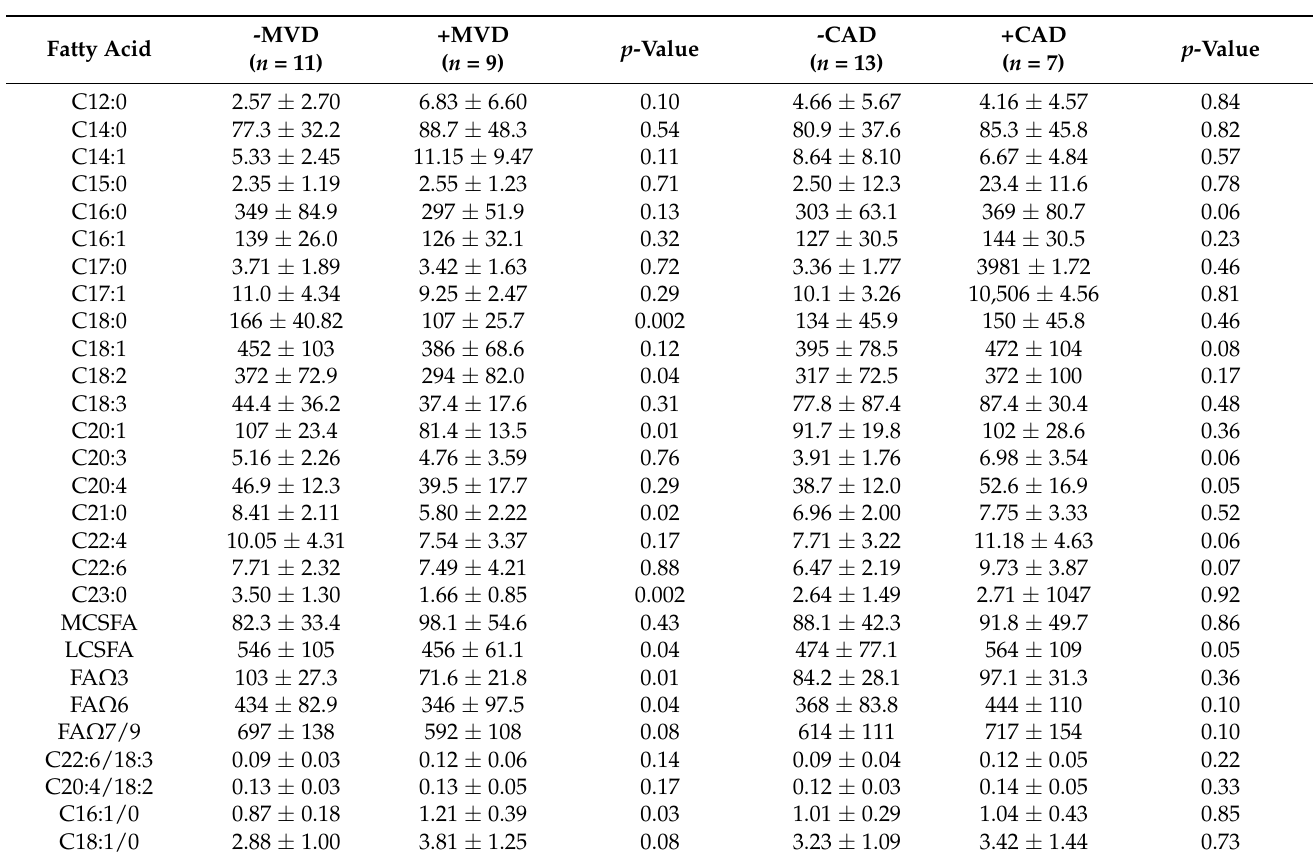
Table 5. Plasma acylglycerol fatty acid levels of participants by microvascular dysfunction (MVD) and non-obstructive CAD